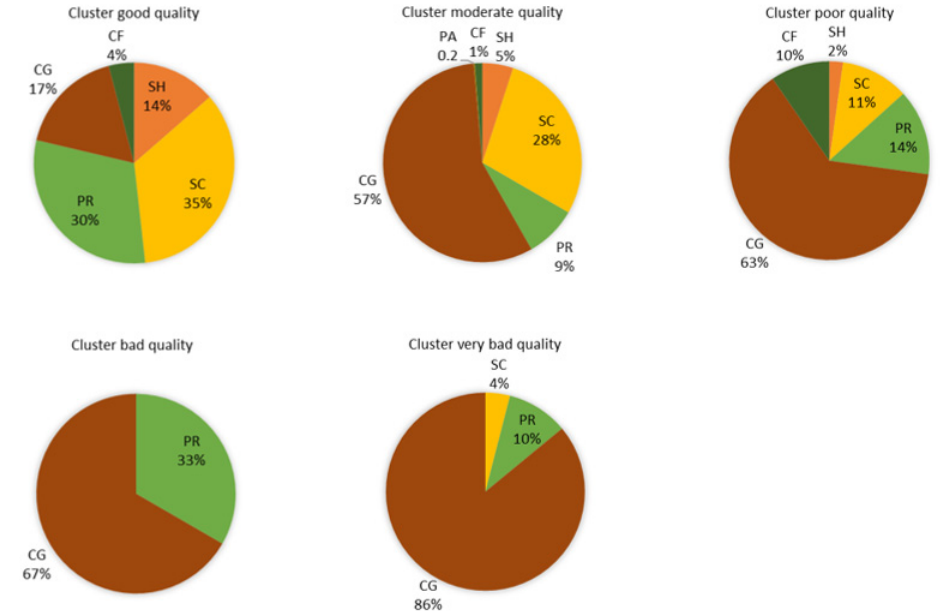
Figure 4. Relative abundance of functional feeding groups clustered based on BMWP-Col water quality classes where CF, SH, SC, PA, PR, and CG refers to the collector-filterers, shredders, scrapers, parasites, predators, and collector-gatherers, respectively.